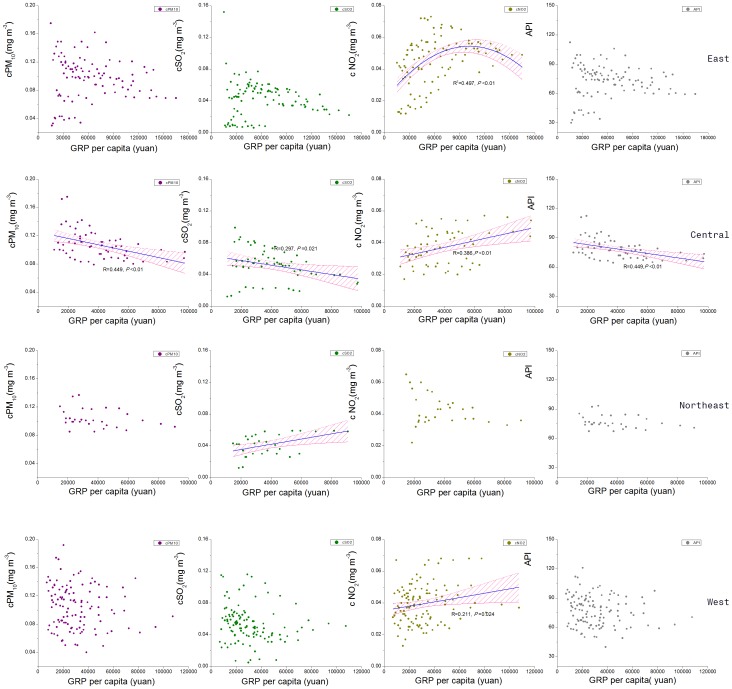
Regression curves between GRP per capita and air pollutant index (PM10, SO2, NO2, API) in four economic regions during 2003–2012.The blue line is the regression line and the pink area the 95% confidence limits.